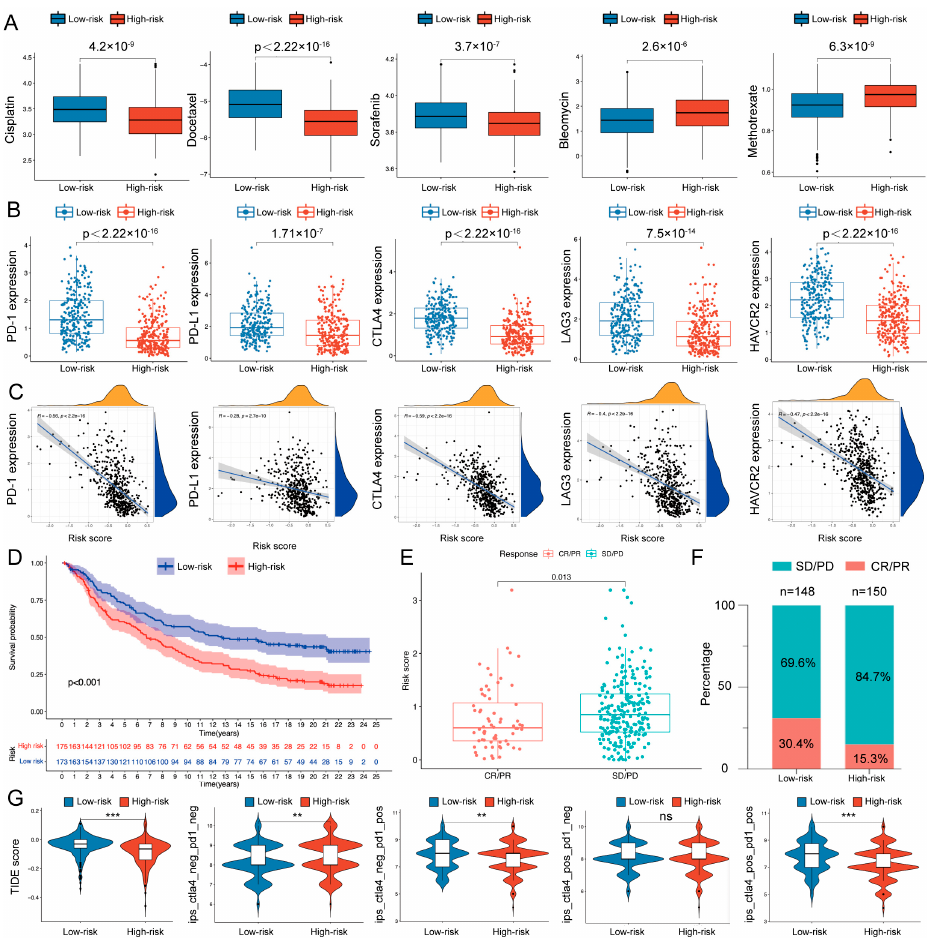
Figure 4. Therapeutic benefit prediction and validation. ( A ) The differences in the estimated IC50 levels of cisplatin, docetaxel, sorafenib, bleomycin, and methotrexate between the two groups. ( B ) Expression levels of PD-1, PD-L1, CTLA4, LAG3, and HAVCR2 in the two risk groups. ( C ) Correlation analysis between risk score and the ICI expression level. ( D ) Survival analysis for low- and high-risk groups in the anti-PD-L1 immunotherapy cohort. ( E ) Risk scores of patients with different clinical responses. ( F ) Percentage of response (CR/PR) and non-response (SD/PD) patients in the two risk groups. ( G ) TIDE score and IPS score reflected the response to ICIs. ns, p > 0.05, * p < 0.05, ** p < 0.01, *** p < 0.001.